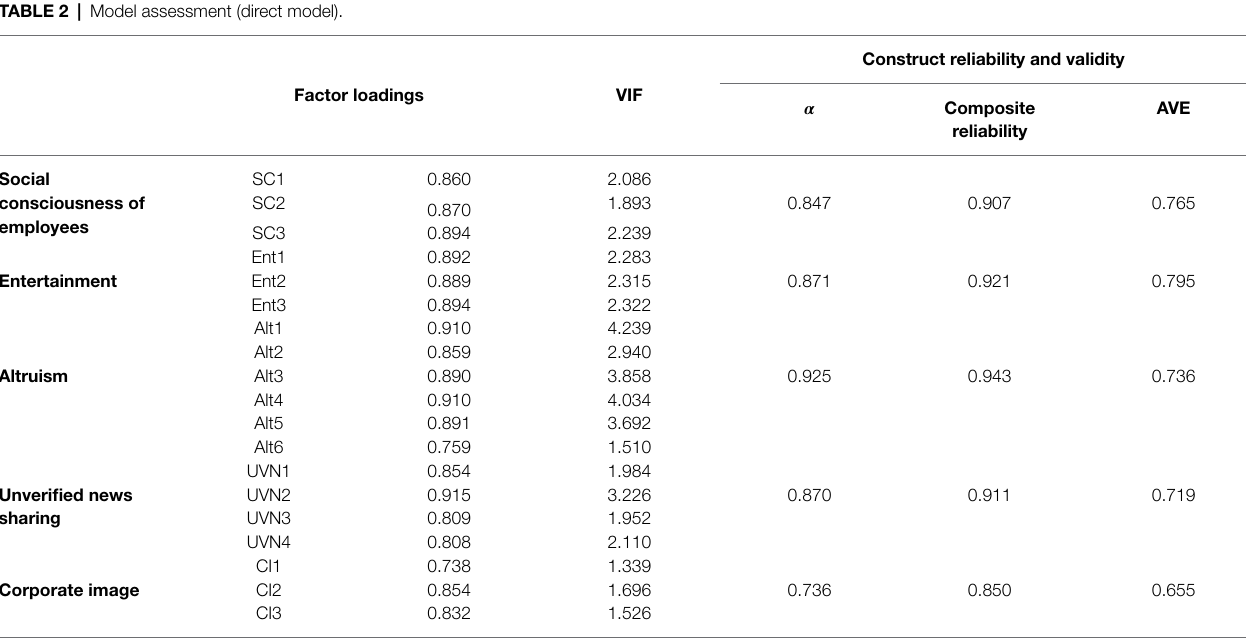
TABLE 2 | Model assessment (direct model).